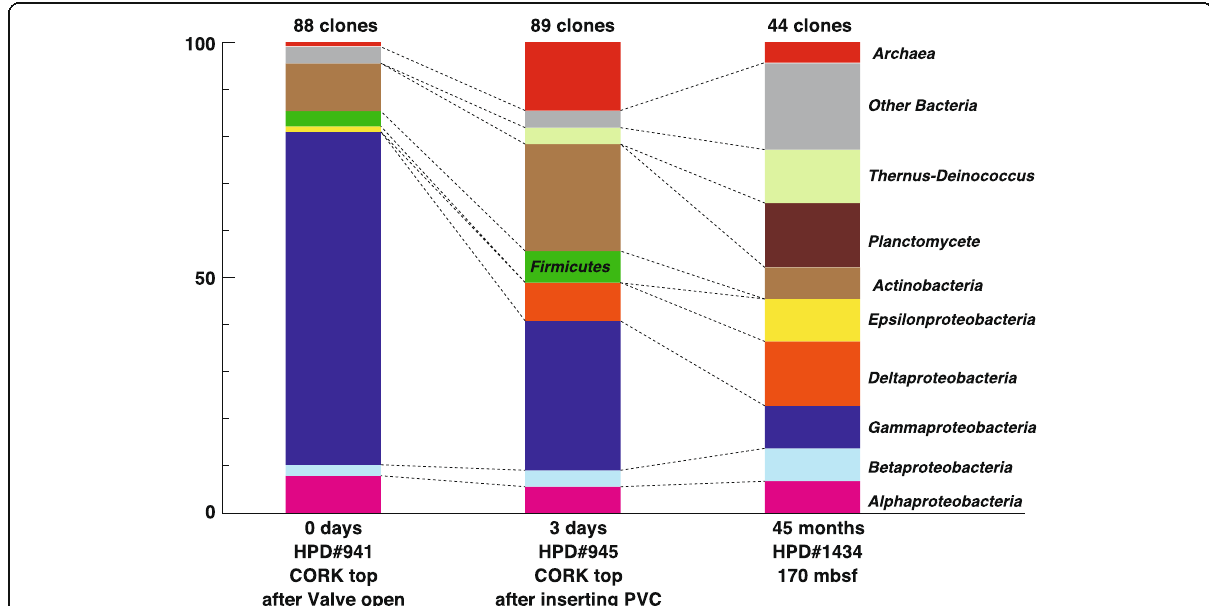
Fig. 6 Phylotype compositions of 16S rRNA genes in microbial communities of the CORK fluids. In total, 88, 89, and 44 clones were sequenced for the microbial communities in the CORK fluid samples at the time of valve opening (0 day), 3 days, and 45 months after the valve was opened,